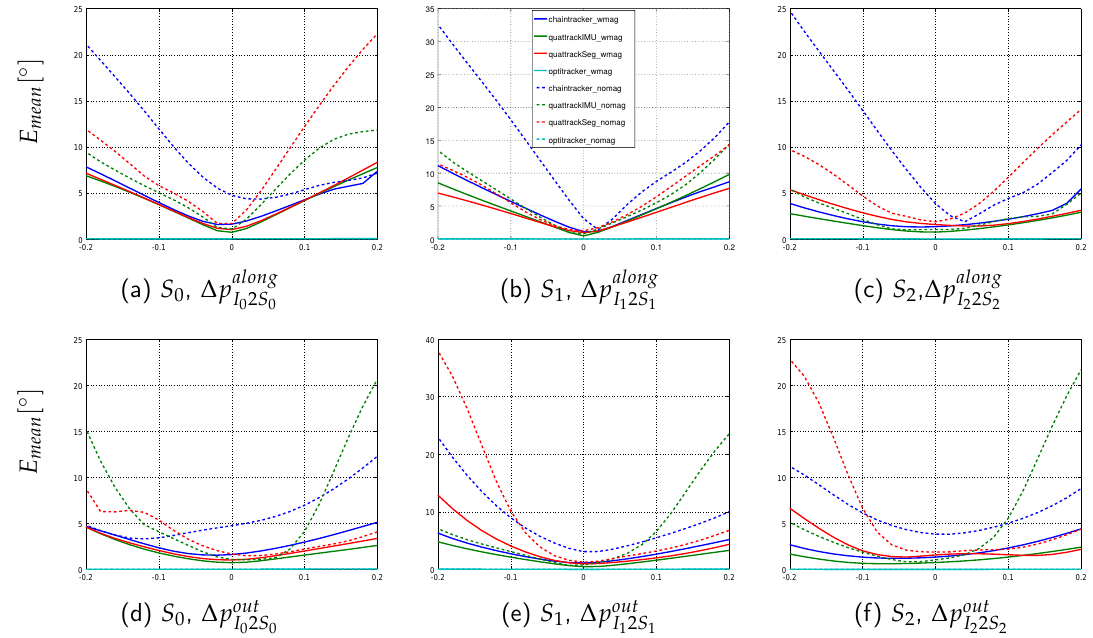
Figure 6. Simulation scenario: Per segment mean angular error distributions on sim-fast for along-bone and out-of-bone I2S position calibration errors (cf. Section